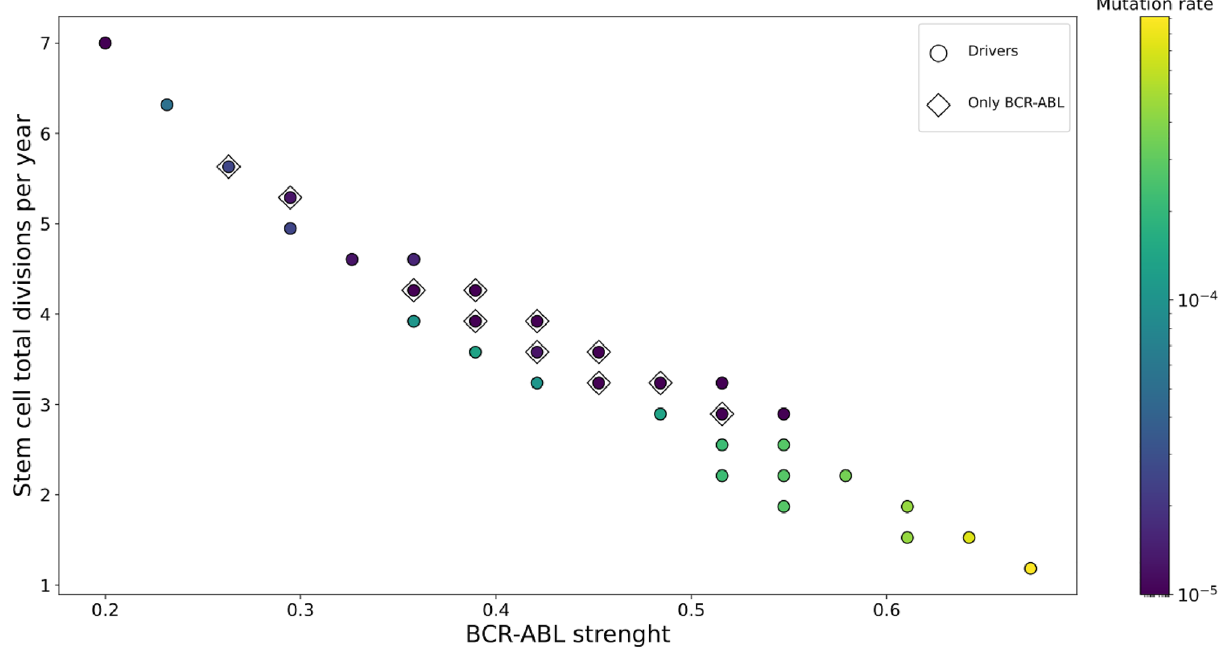
with the stem cell divisions per year. Slow-dividing HSCs need a high-strength BCR::ABL1 mutation to present a characteristic chronic phase and accelerated phase median duration. Diamond markers correspond to